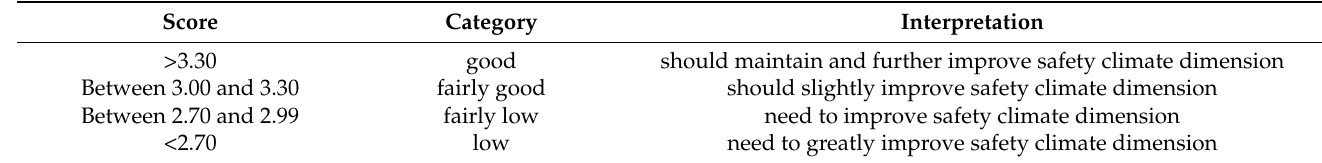
Table 2. Categorization and interpretation of safety climate scores [28].